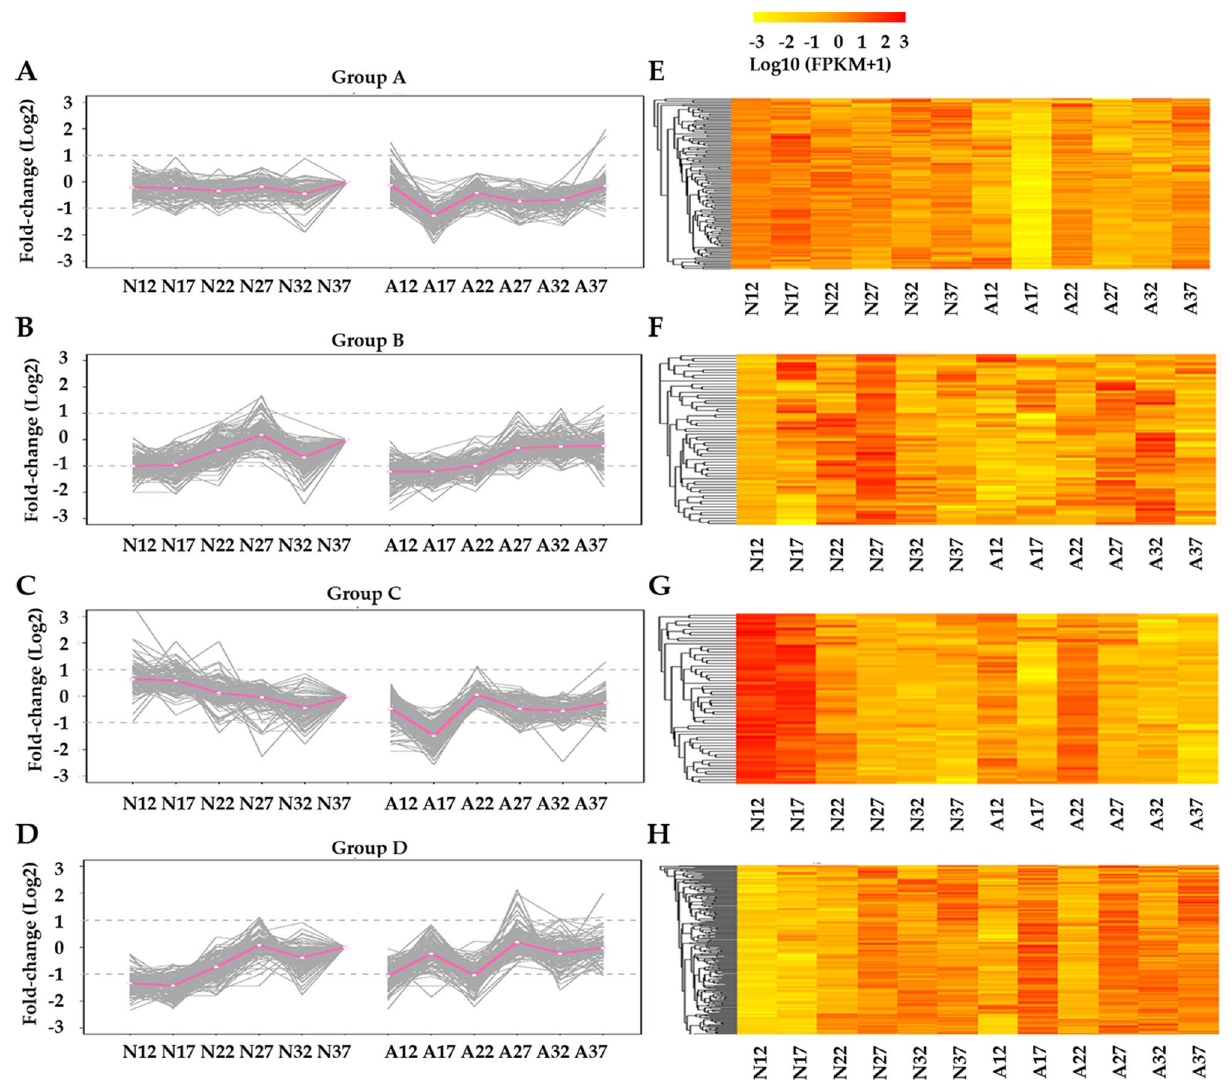
Figure 4. The expression patterns and heatmaps of representative DEGs groups. ( A – D ) y-axis gives log2 value of fold change. ( E – H ) heatmap presents log10 value of FPKM. The expression patterns were performed using 12 DAF as the baseline. “N12” represents 12 DAF of normal fruits; “A12” represents 12 DAF of abnormal